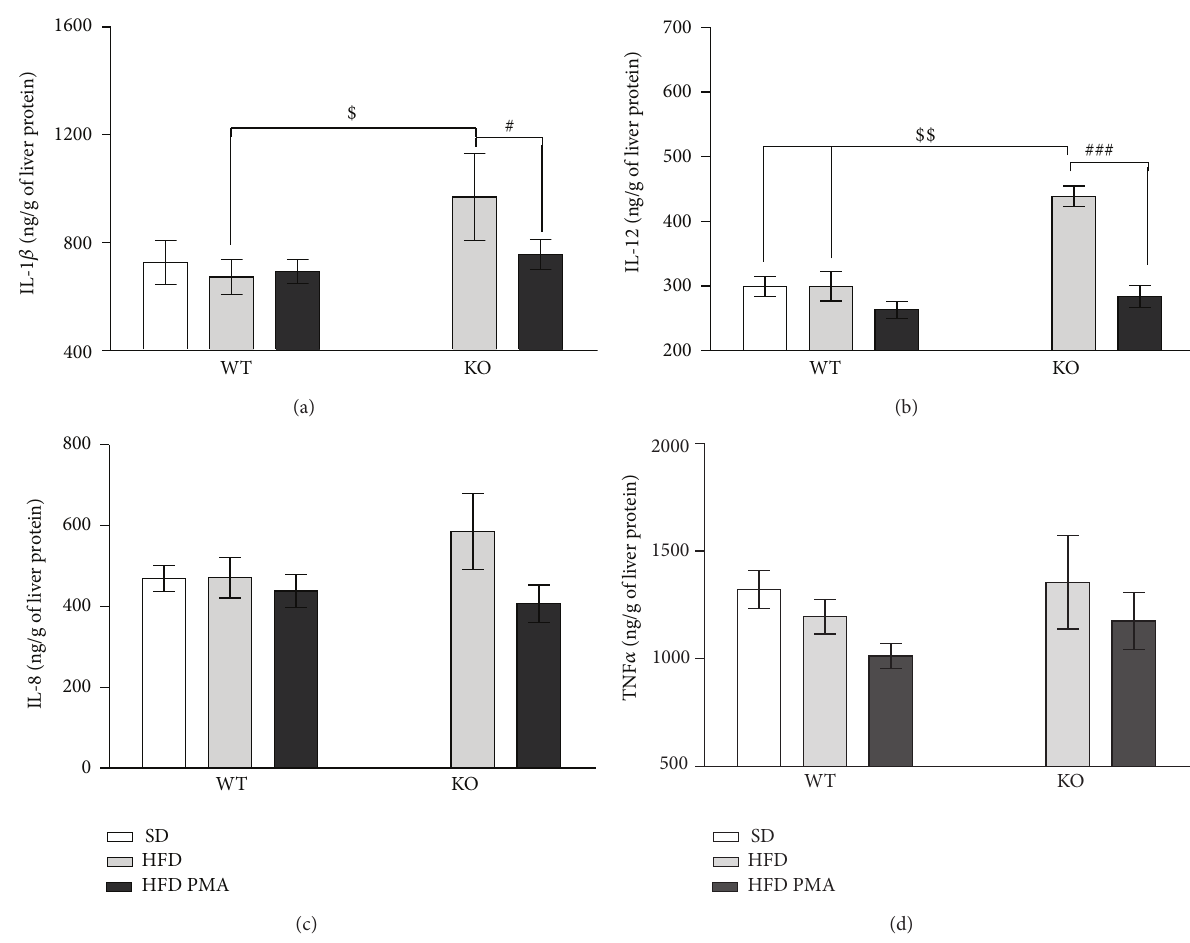
Figure 5: Hepatic levels of interleukin-1 𝛽 (IL-1 𝛽 ) (a), interleukin-12 (IL-12) (b), interleukin-8 (IL-8) (c), and tumor necrosis factor- 𝛼 (TNF 𝛼 ) (d) in WT mice fed with a standard diet (SD) or WT and PPAR 𝛼 -knockout (KO) mice fed with a high-fat diet and treated with oleic acid (HFD) or palmitoleic acid (HFD PMA). The data are presented as mean ± SEM. # 𝑃 < 0.05 and ### 𝑃 < 0.001 HFD versus HFD PMA; $ 𝑃 < 0.05 and $$ 𝑃 < 0.01 KO versus WT (one-way ANOVA followed by Bonferroni correction).